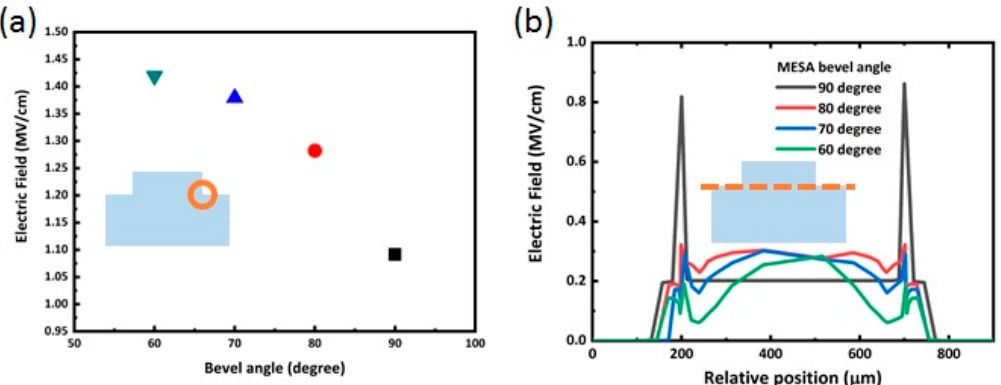
Figure 8. ( a ) Electric field magnitude at the bottom of a 2- µ m mesa for di ff erent bevel angles at a reverse bias of 500 V. ( b ) Electric field distribution along the bottom of a 6- µ m mesa for di ff erent bevel angles at a reverse bias of 500 V.